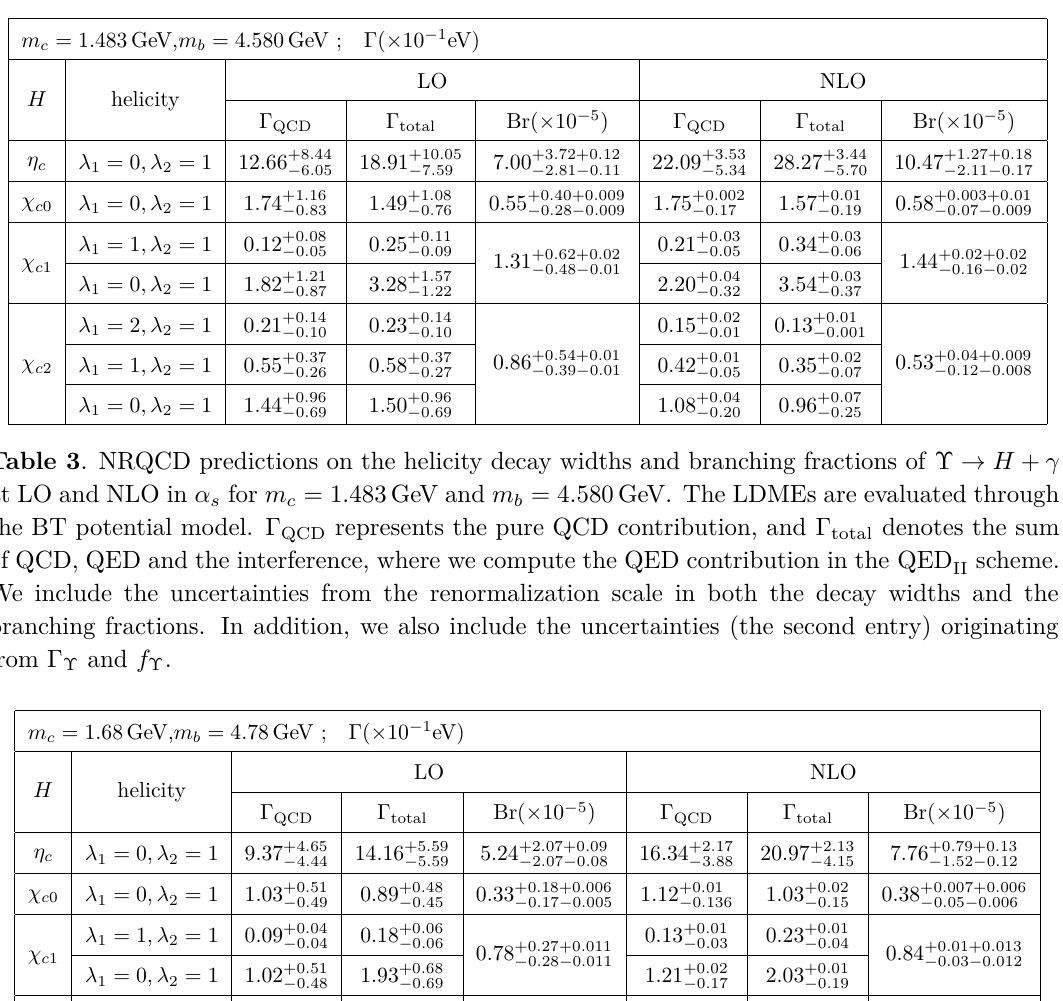
Table 4 . NRQCD predictions on the helicity decay widths and branching fractions of Υ → H + γ at LO and NLO in α s for m c = 1 . 68 GeV and m b = 4 . 78 GeV. We use the same conventions as in table 4. Recently, Belle collaboration had measured the branching fraction Br(Υ → χ